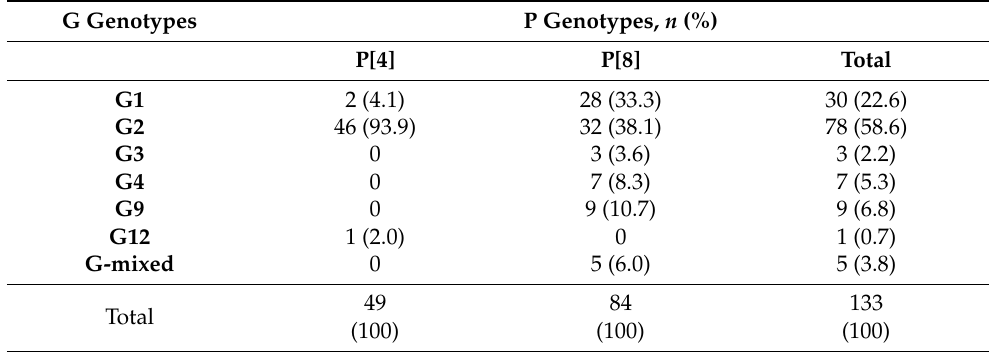
Table 2. Distribution of rotavirus G and P genotypes among children and adults with gastroenteritis in Vojvodina, Serbia during the period 2012–2018